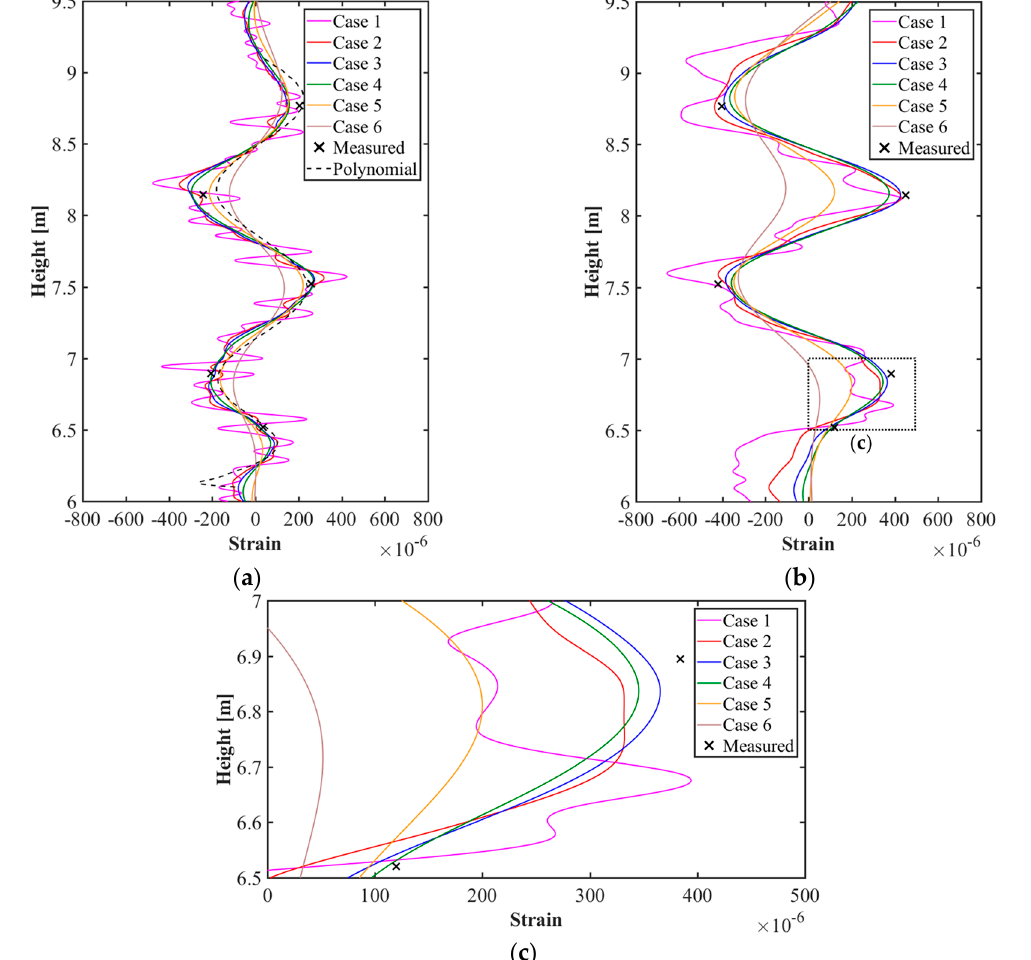
Figure 18. Comparison of strain values from ESGs and finite element models for cases 1–6: ( a ) Vertical strain curves; ( b ) Horizontal strain curves; ( c ) Comparison of detailed strain curves.